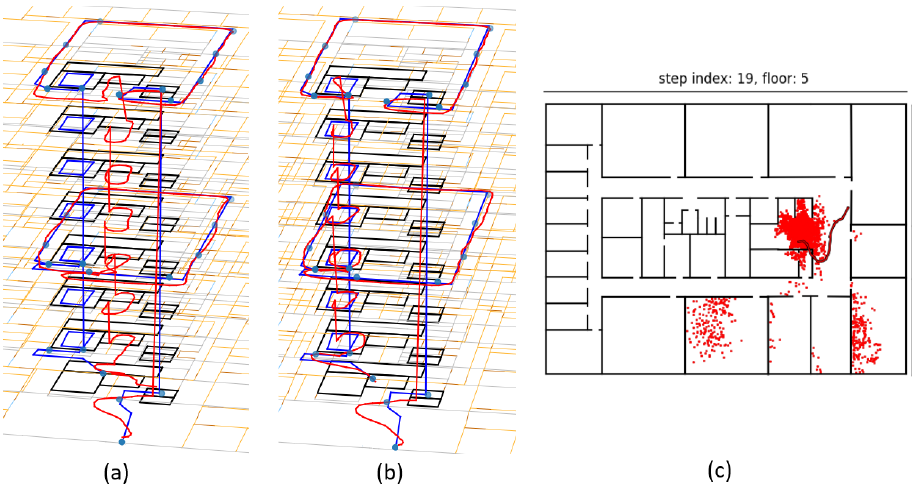
Figure 12. Plot of the estimated trajectory (red) and true trajectory (blue) by the backtracking particle filter in batch mode with ( a ) and without ( b ) using stairs detections as measurement updates. The distribution of particles when entering the staircase ( c ) is the same in both